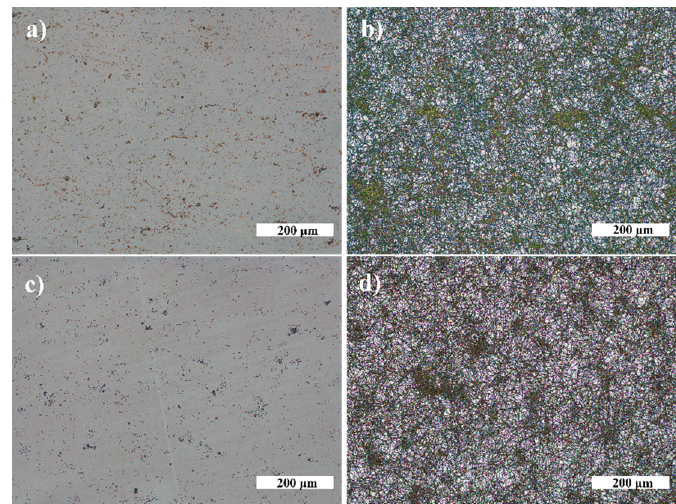
Figure 10. N. sicca biofilms on NP (magnification ×10): ( a ) TiO 2 —20 °C, AgNP; ( b ) TiO 2 —20 °C, AuNP; ( c ) TiO 2 —500 °C, AgNP; and ( d ) TiO 2 —500 °C, AuNP. The growth of V. parvula on AuNP was significantly different as it was for N. sicca